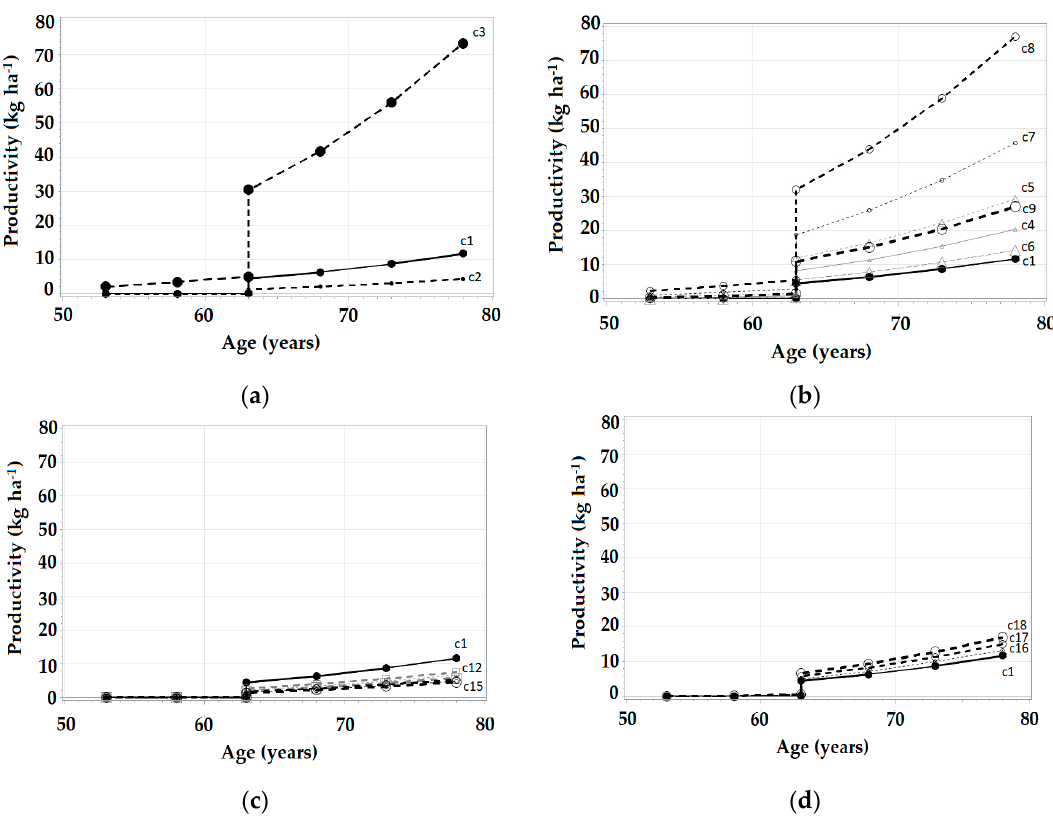
Figure 4. Total mushroom productivity by climate scenarios for the G35 silvicultural treatment (( a ): real average; ( b ): wetter; ( c ): drier; ( d ): hotter scenarios).